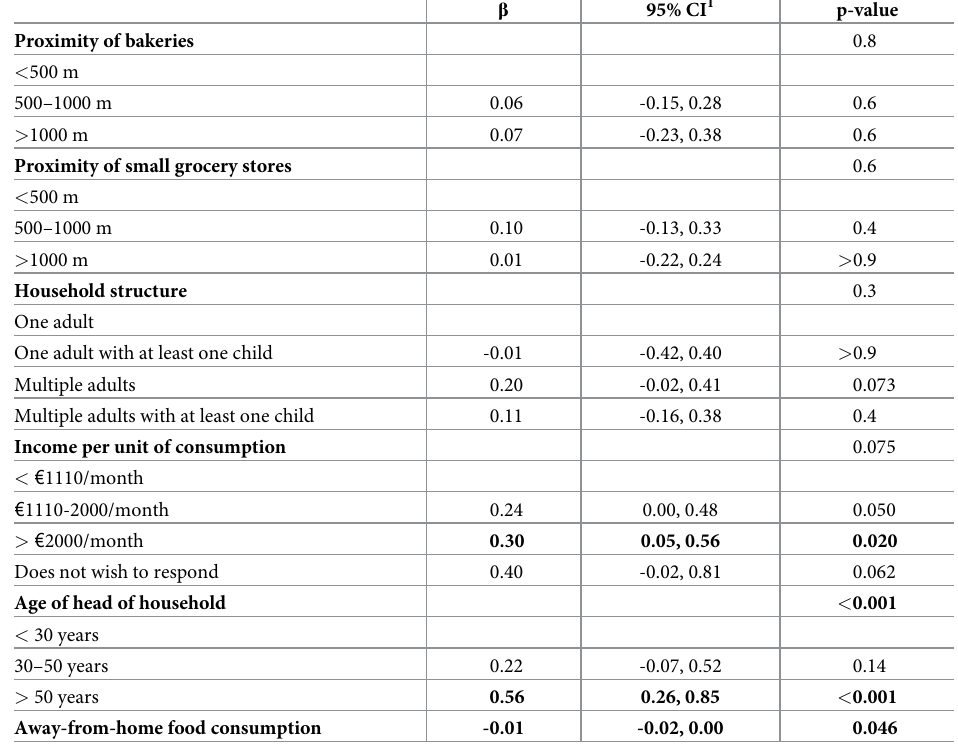
Table 3. Adjusted multilevel model of the associations between proximity of food outlets around the home and the nutritional quality of food purchases (r-HPI z-score) (N =